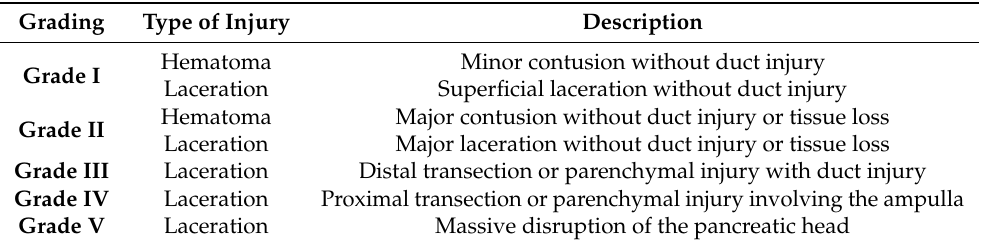
Table 2. Classification of pancreatic trauma according to the American Association for the Surgery of Trauma (AAST)